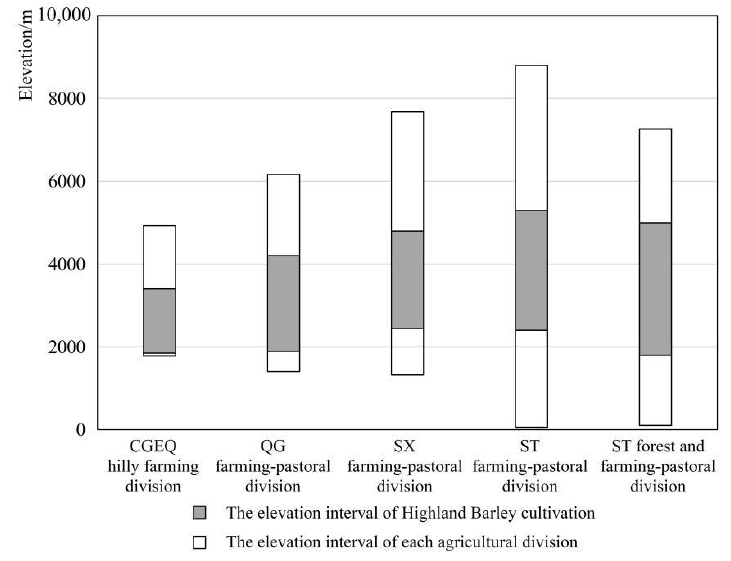
Figure 9. The elevation interval of Highland barley cultivation and each agricultural division.